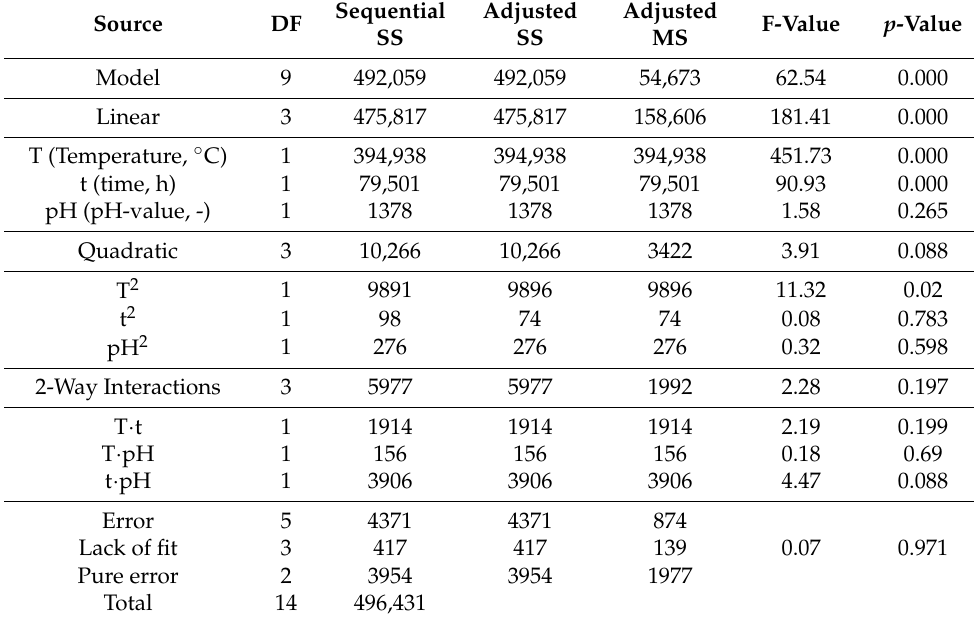
Table A3. ANOVA for the model of NH 4 -N. DF: degrees of freedom, SS: sum of squares, MS: mean